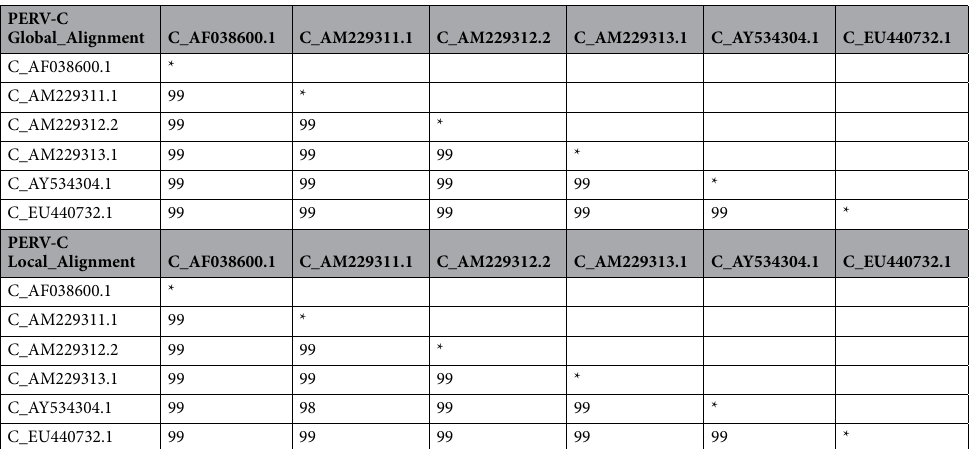
Table 2. Identity (%) among PERV-C and PERV-A/C subgroups by global and local alignments.